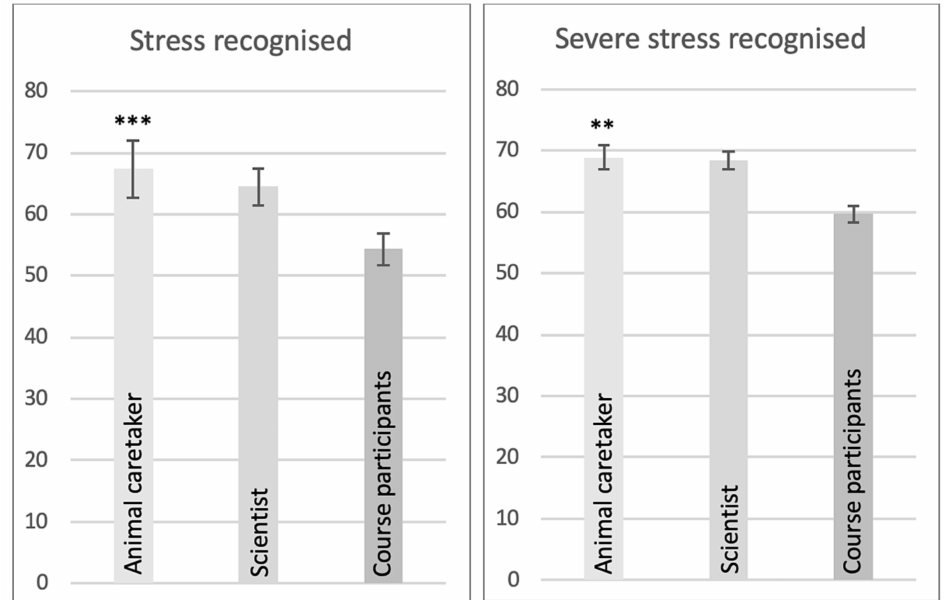
Figure 2. Comparison of the mean values and standard errors for the different groups. Y -axis = mean values agreement with the answer in %. * p -value < 0.05, ** p -value < 0.01, *** p -value < 0.001. The group of animal caretakers was significantly better at the individual questions, especially compared to the course participants (evaluation according to Bonferroni): general response rate p -value < 0.001 compared to course participants, recognition of healthy animals p -value 0.033 compared to scientists and p -value < 0.001 compared to course participants, recognition of stressed animals p -value < 0.001 compared to course participants and recognition of severely stressed animals p -value 0.001 compared to course